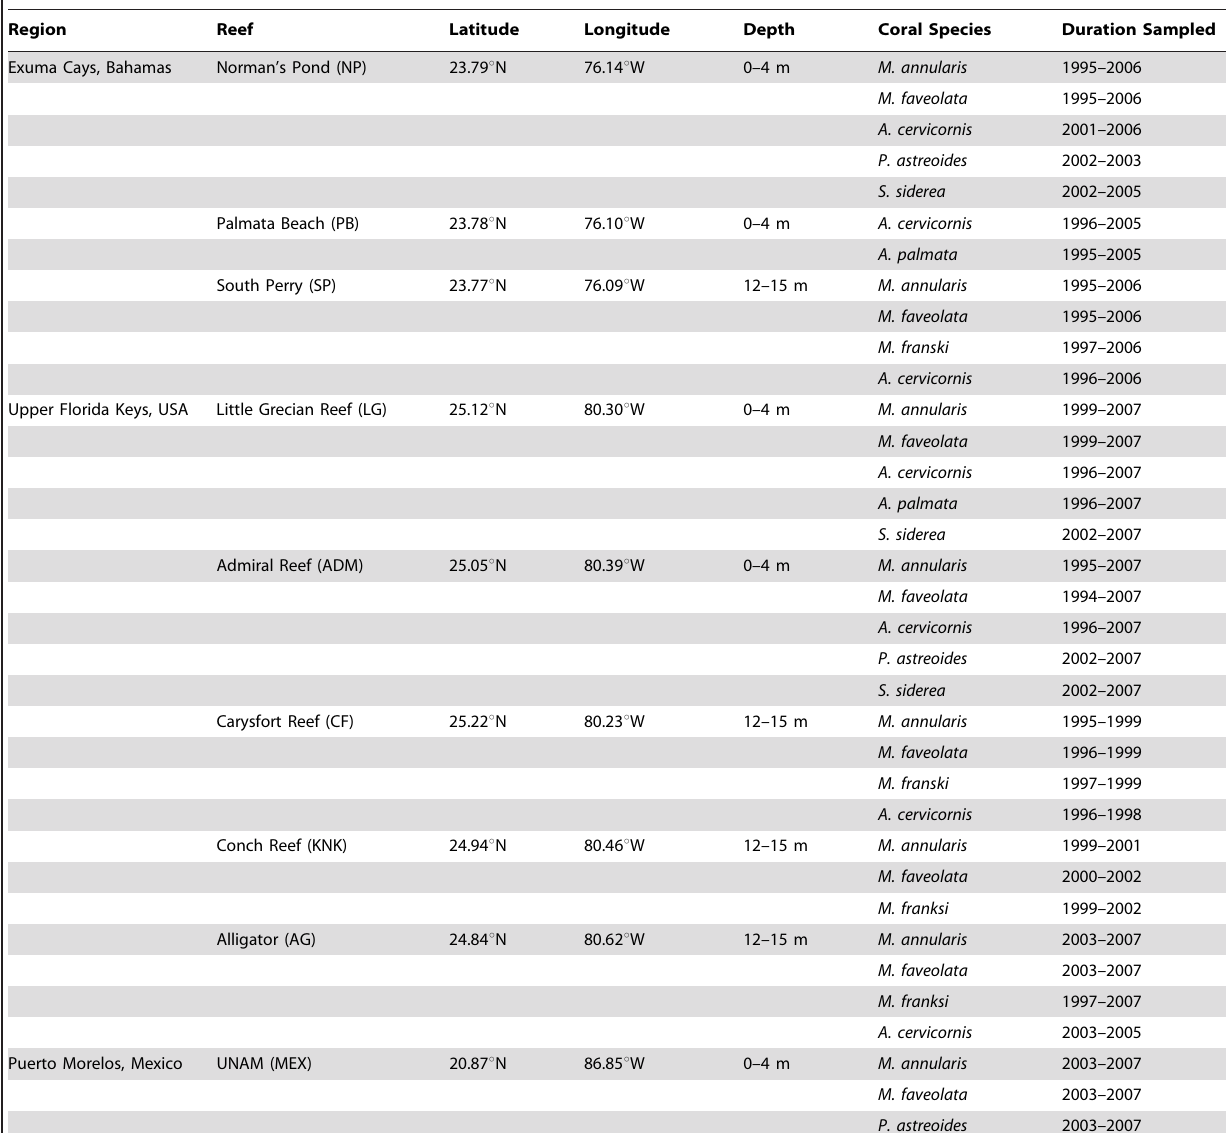
Table 1. Species of corals sampled at each reef in this